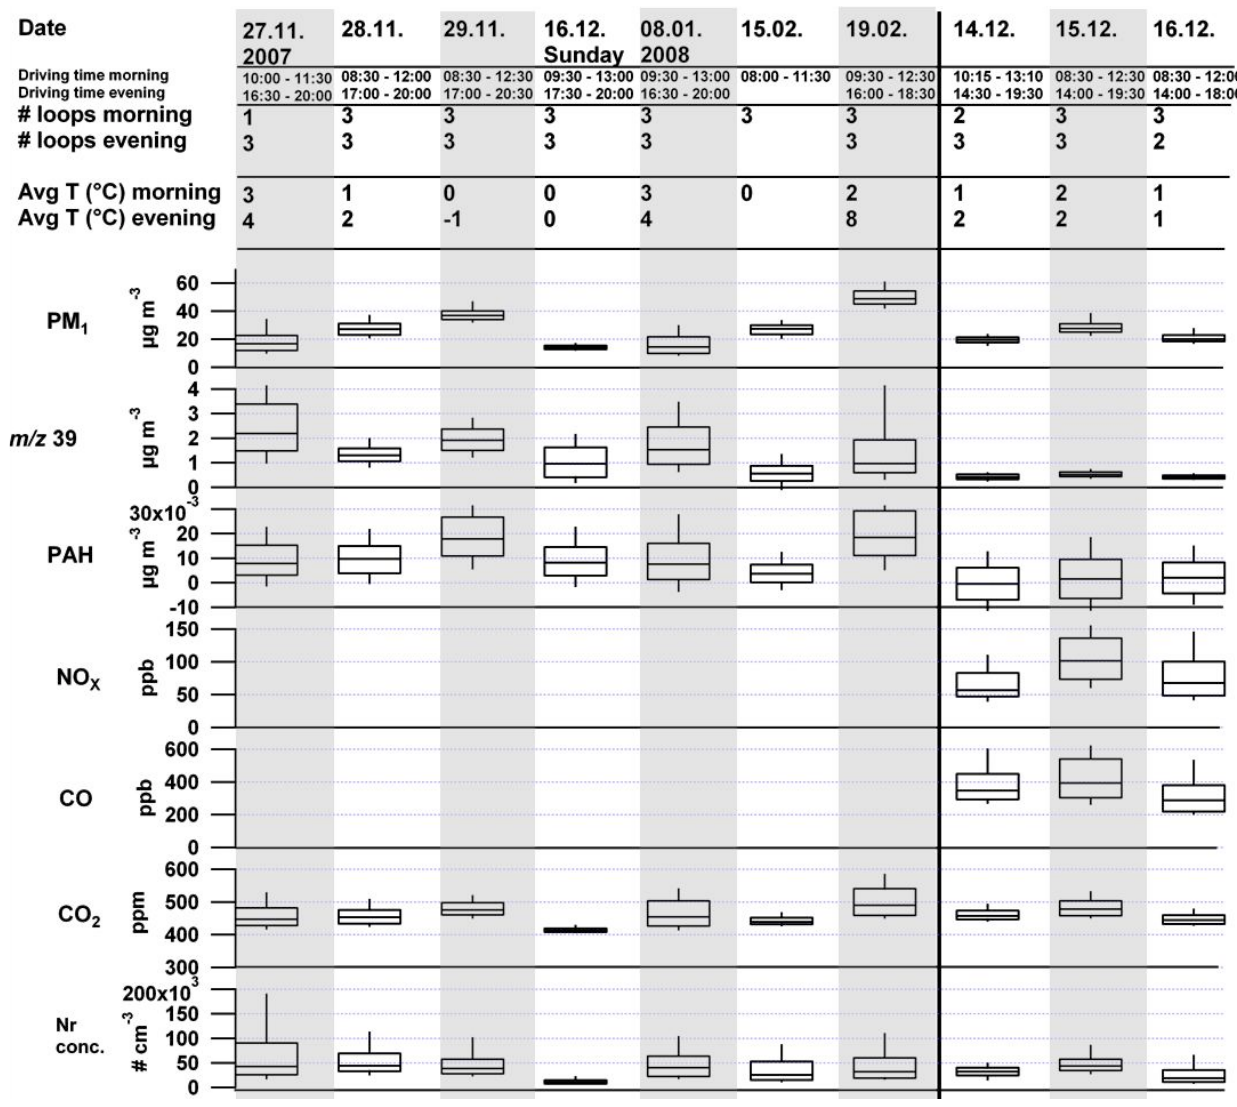
Figure 1: Overview of drives. Number of loops states how many times the measurement route in Fig. 6 was driven in the given time interval. PM 1 includes AMS and MAAP measurements; m/z 39 and PAH mass concentrations were measured by Q-AMS. Boxes represent upper and lower quartiles, horizontal lines correspond to the median, and whiskers denote 10%- and 90%-percentiles. The vertical line shows the division of the dataset into part 1 and part 2. 16 December 2007 is the only Sunday measured, all other days are weekdays.